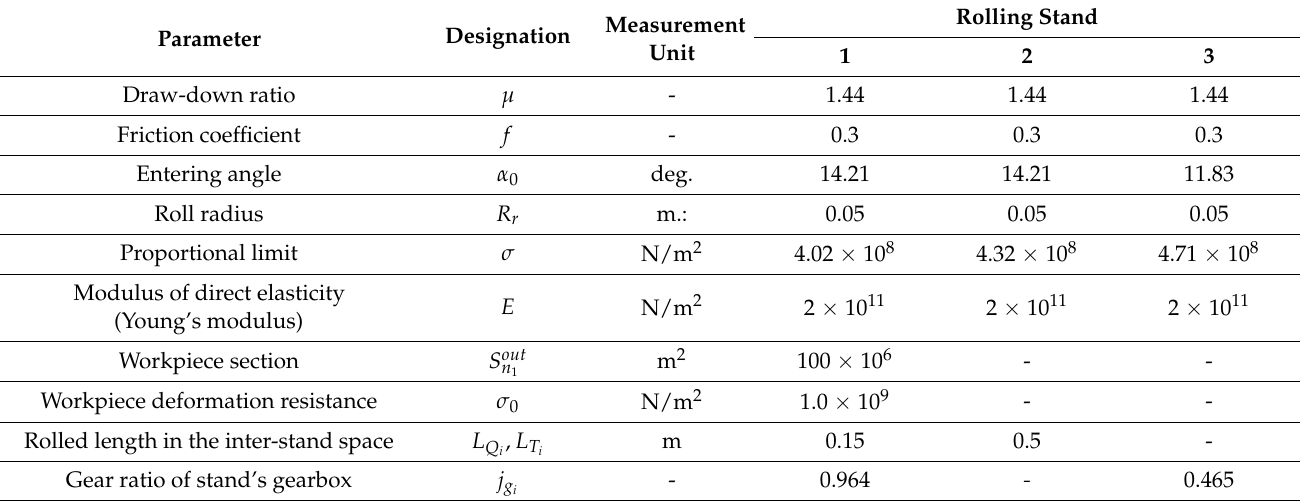
Rolling Stand Measurement Unit 1 2 3